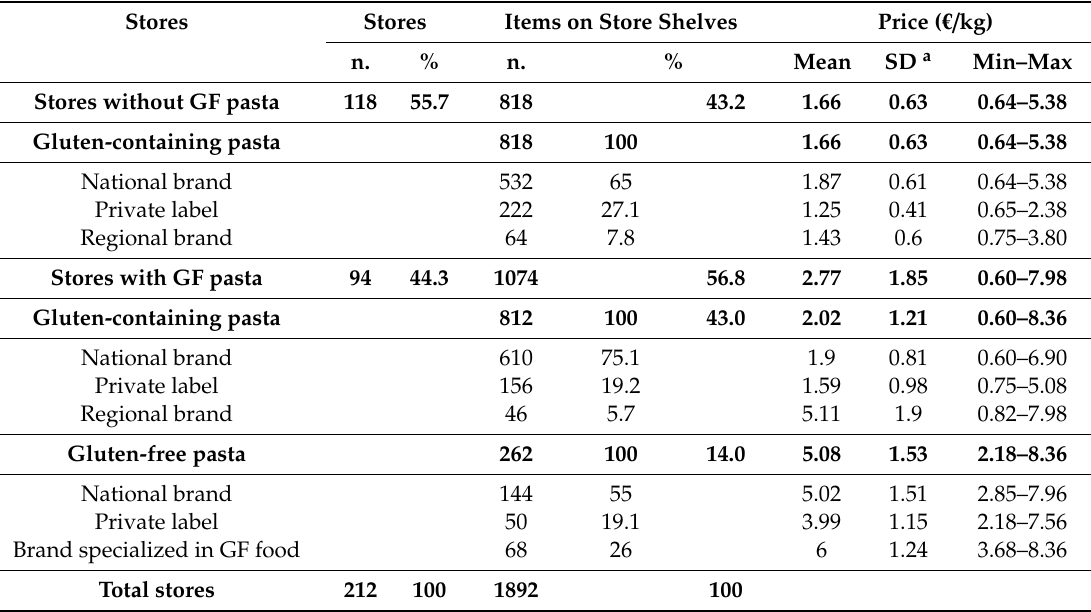
Table 1. Descriptive statistics of the sample. GF = gluten-free.